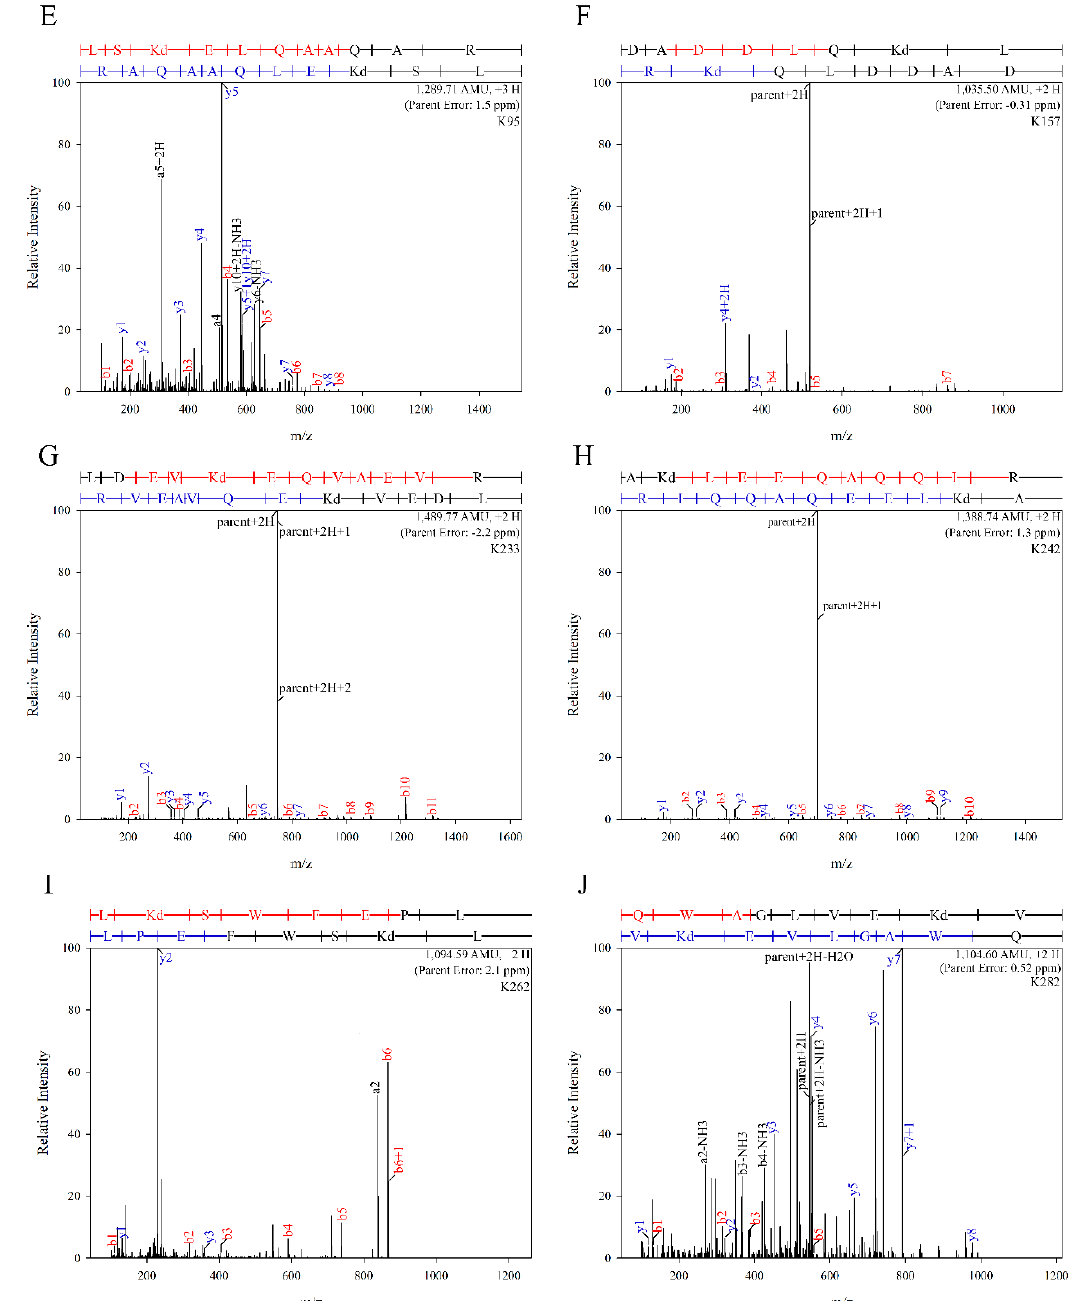
Figure 2. LC-MS / MS profiles of major modified sites in acro-apoE3. Purified apoE3 was treated with acrolein, subjected to in-gel digestion and analyzed by nano LC-MS / MS as described under Materials and Methods and Supplemental Information. The panels show spectra of peptides where major acrolein modification of the di ff erent sites were observed: ( A ): K1; ( B ): K69; ( C ): K72; ( D ): K75; ( E ): K95; ( F ): K157; ( G ): K233; ( H ): K242; ( I ): K262; and, ( J ): K282.